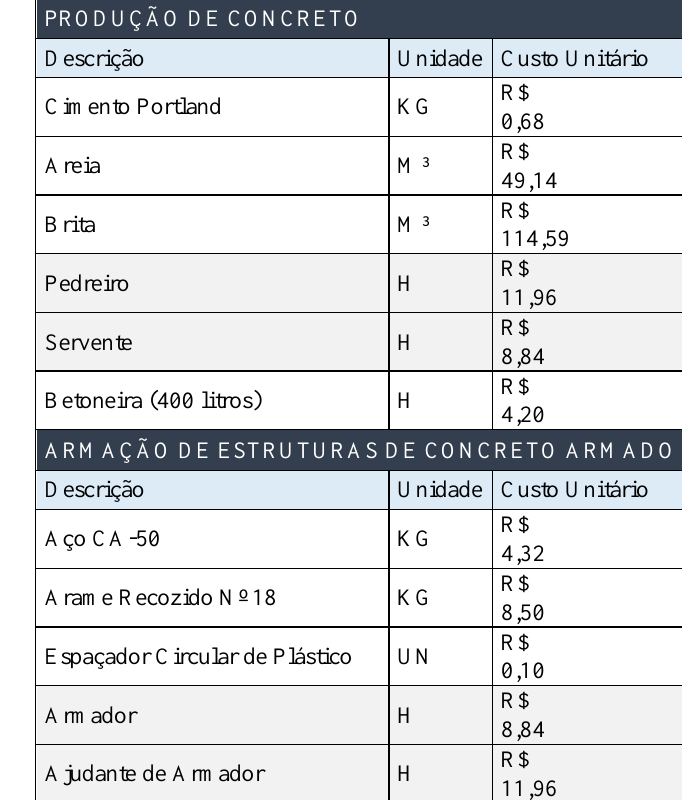
Tabela 8: Custos unitários adotados pela